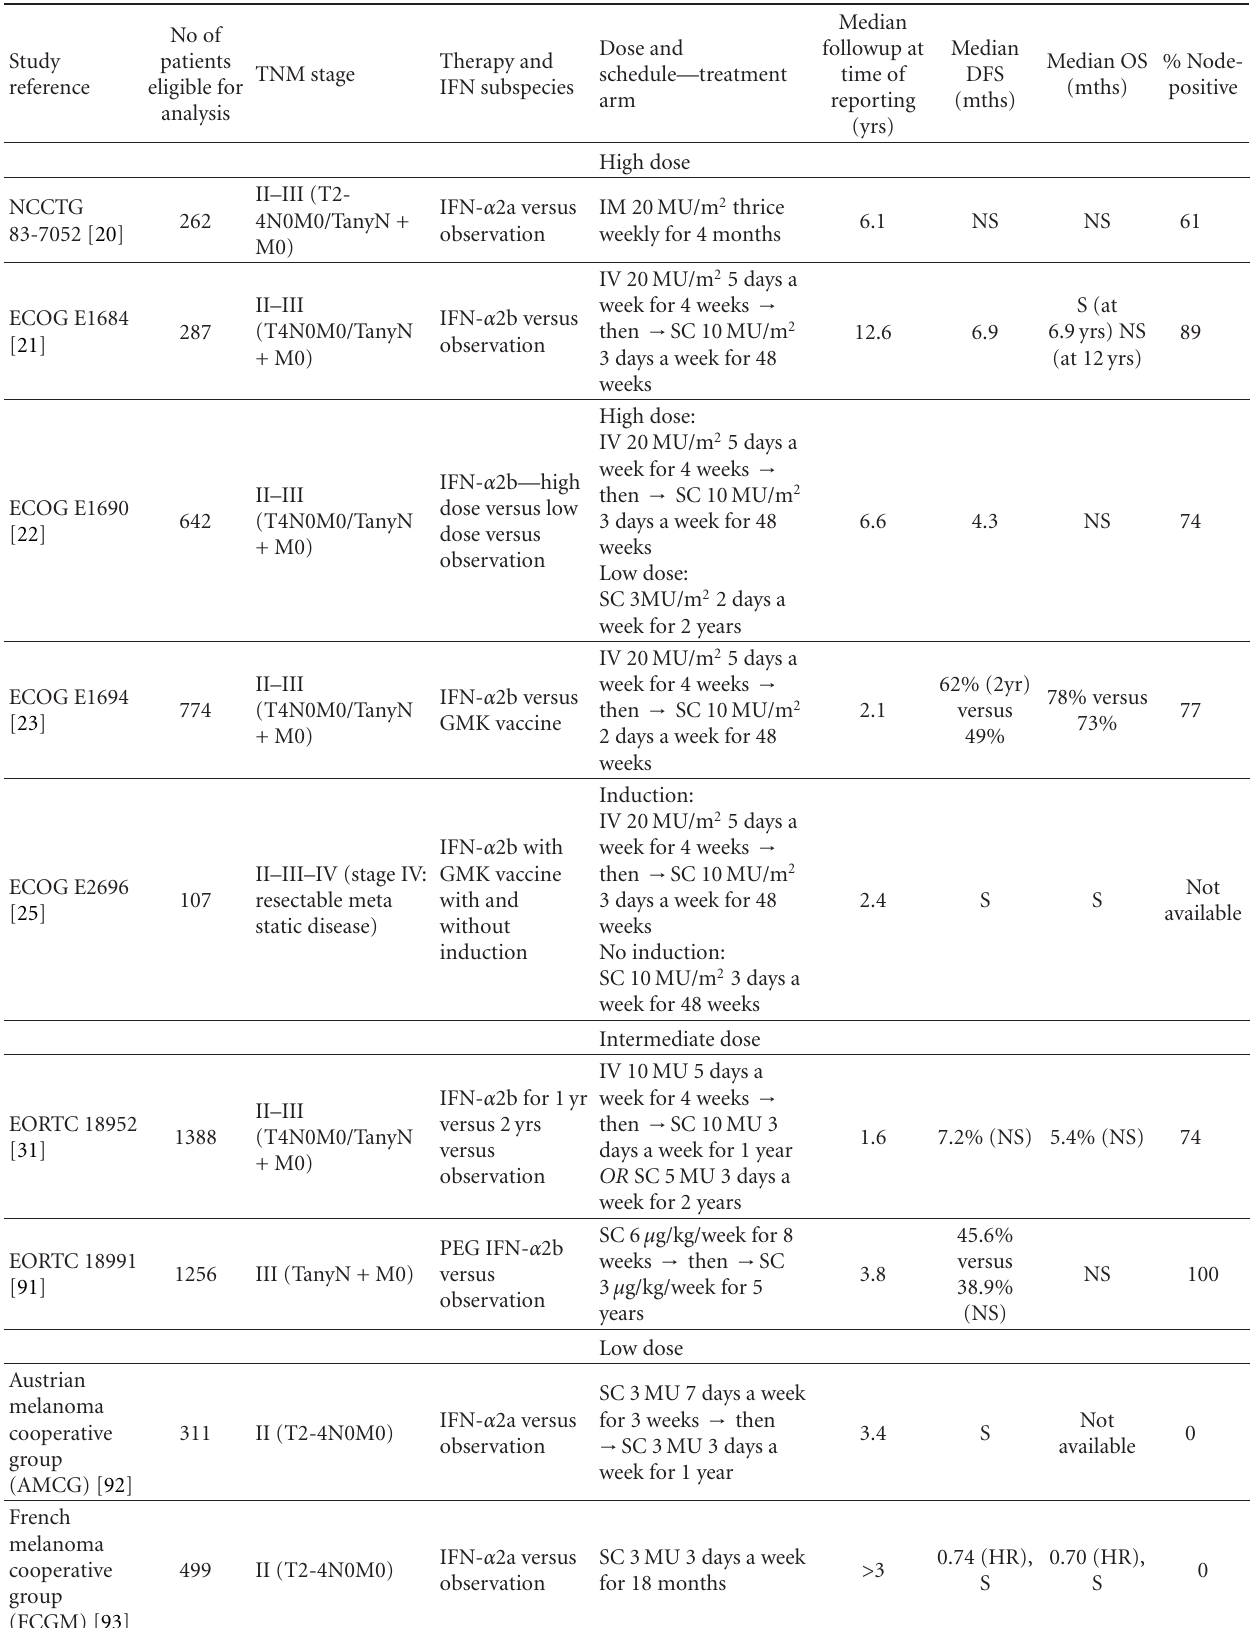
Table 2: Phase III studies of IFN- α for metastatic